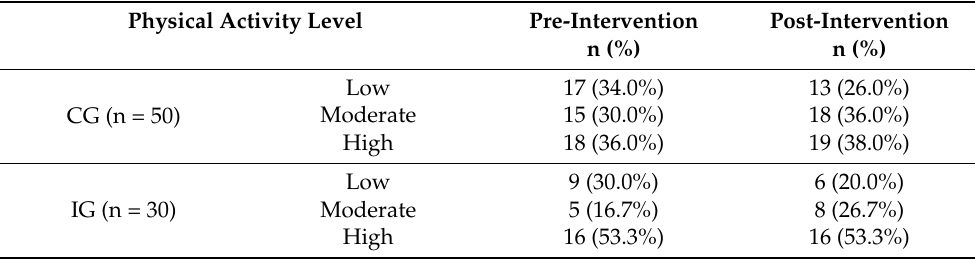
Table 3. Frequencies of physical activity levels in IG and CG (pre- and post-intervention).